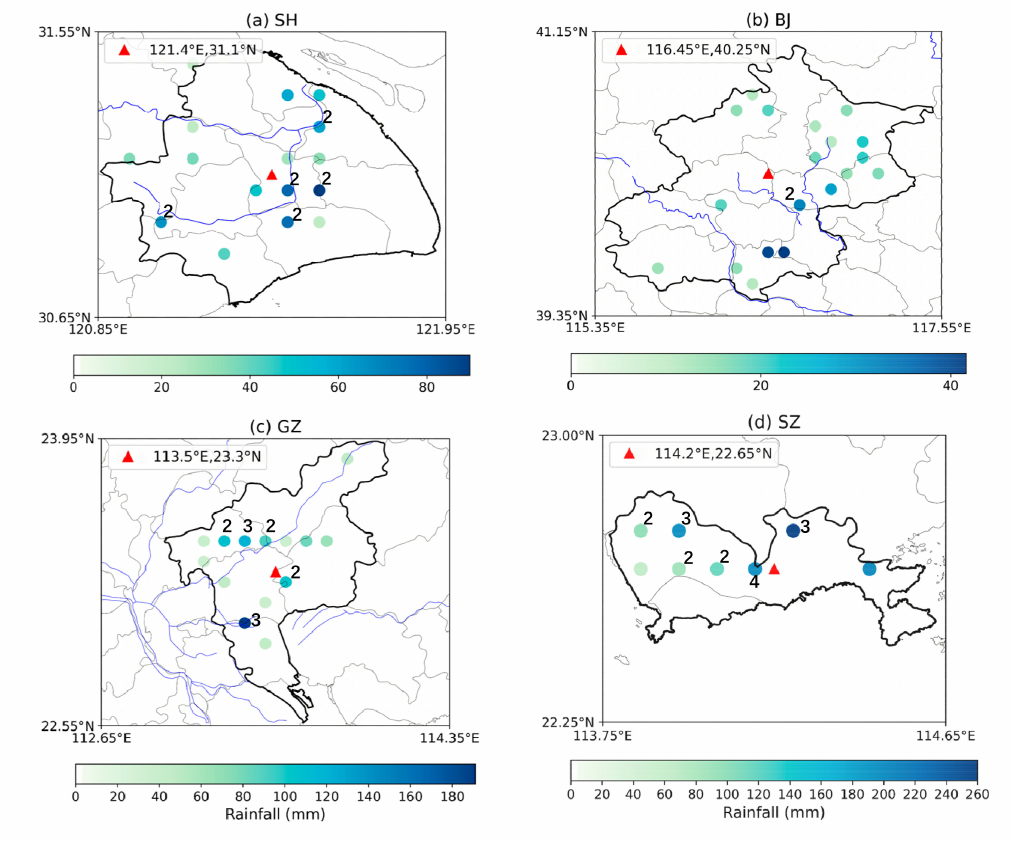
Figure 12. Locations of Rx3h centroids during 2000–2020 (The dot locations are where the Rx3h centroids occur in the cities, and the dot colors indicate the magnitudes of rainfall. The di ff erent numbers reveal the occurrence number of the centroids at the marked location, and the number not marked is one time. Geographic location centers in four cities are represented by a red dot. The blue lines for the nearby